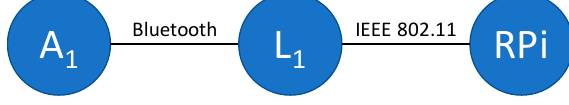
Figure 5. Two-hop deployment scenario.